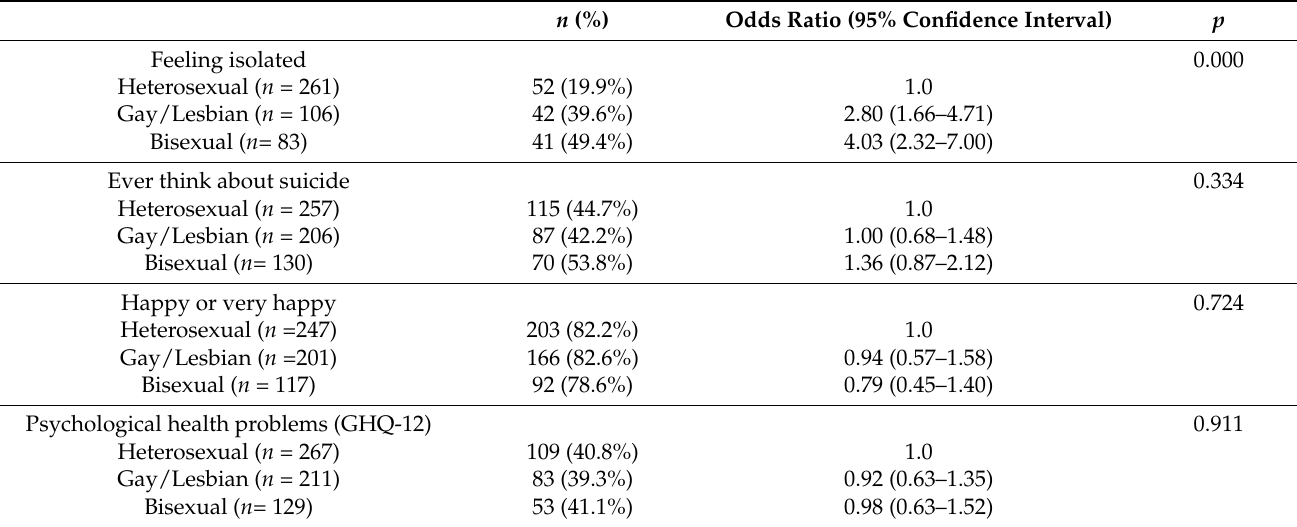
Table 5. Associations between sexual orientation and mental health